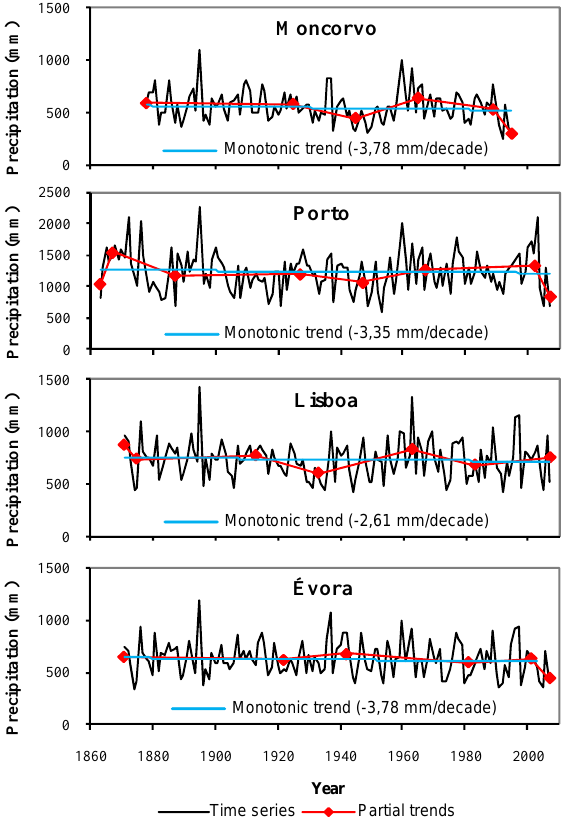
Fig. 1 . Location of ten precipitation measuring stations in mainland Portugal. Fig. 2 . Annual precipitation series from mainland Portugal, and linear monotonic and partial trends. The Sen’s estimator of the slope of the monotonic trends over the full record periods are indicated in the legend.